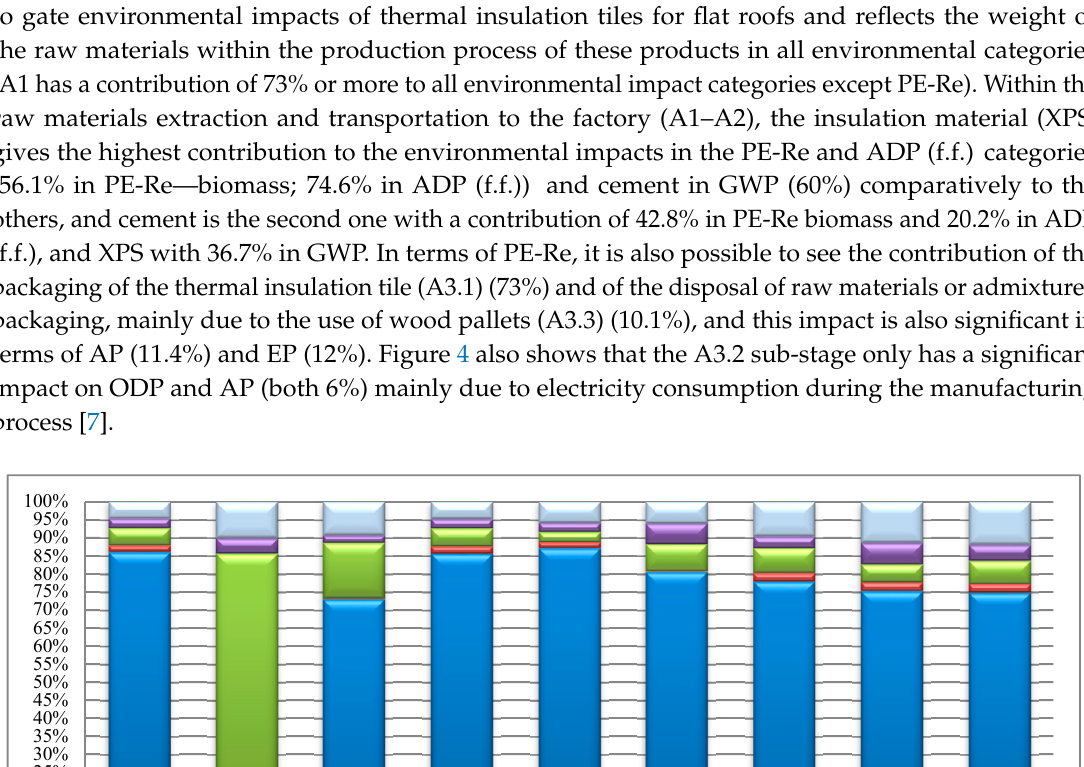
Table 5. LCA results for each sub-stage of the “product stage” (A1–A3) of one default thermal insulation tile for flat roofs.